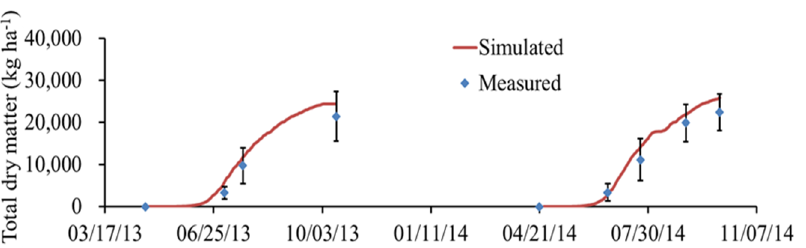
Figure 4. Comparison of measured and simulated total dry matter (TDM) under N312 treatment in loamy clay soil.